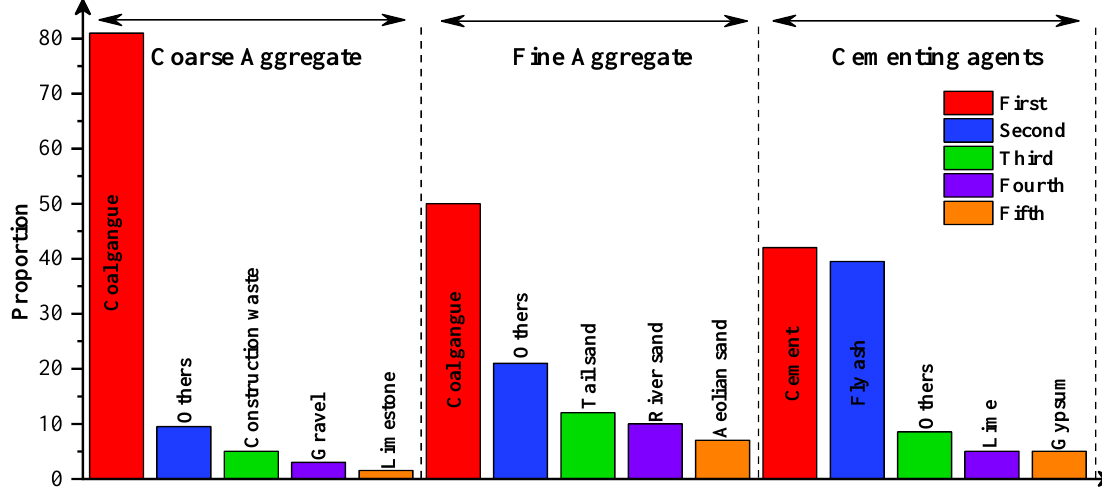
10 of 43 Figure 7. Cemented backfill mining system. 2.2.1. Preparation of Cemented Backfill Material The cemented backfill materials used in underground coalmines commonly consist of water, cementing agents and coarse and fine aggregates, and the percentages of each are illustrated in Figure 8. The solid coarse aggregates are usually composed of cracked gangue, solid construction waste and gravels; the solid fine aggregates are mainly com- posed of coal gangue, tailings and sand (river sand and aeolian sand) and the cementing